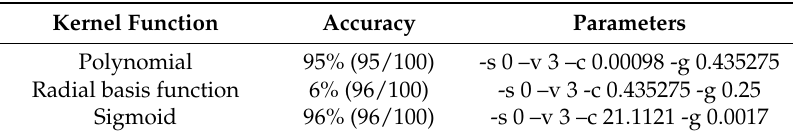
Table 6. The model regression accuracies of different kernel